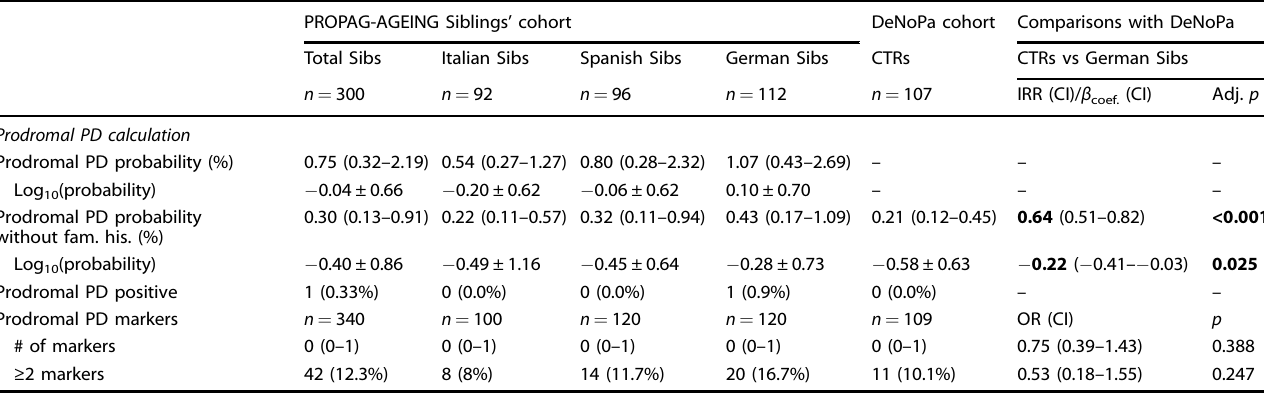
Table 5. Prodromal PD Probability and Markers in siblings and DeNoPa